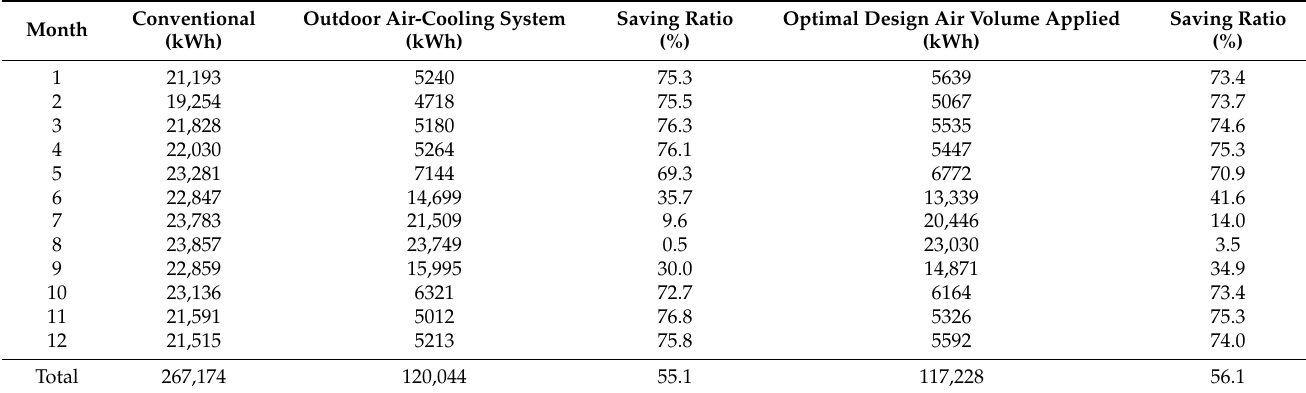
Figure 15. Comparison of the monthly electricity consumption and saving ratio by cooling method. Table 7. Comparison of the monthly electricity consumption and saving ratio by cooling